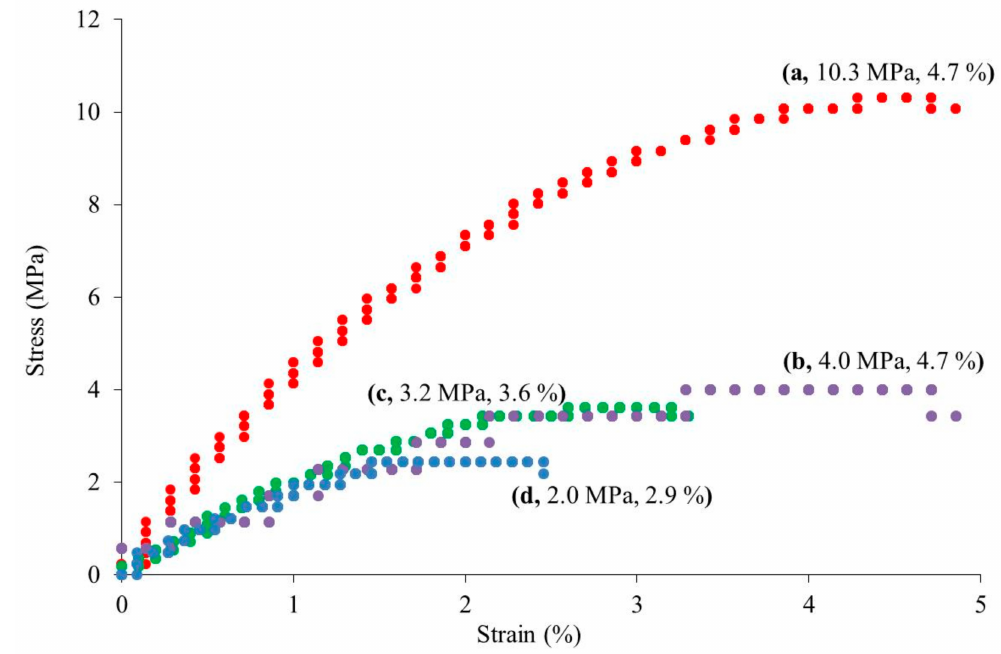
Figure 4. Stress–strain curves of the regenerated celluloses obtained by the lyophilization of the hydrogels ( a – d , Entries 1-4) under a tensile mode. Values of tensile strength and elongation at break are shown in